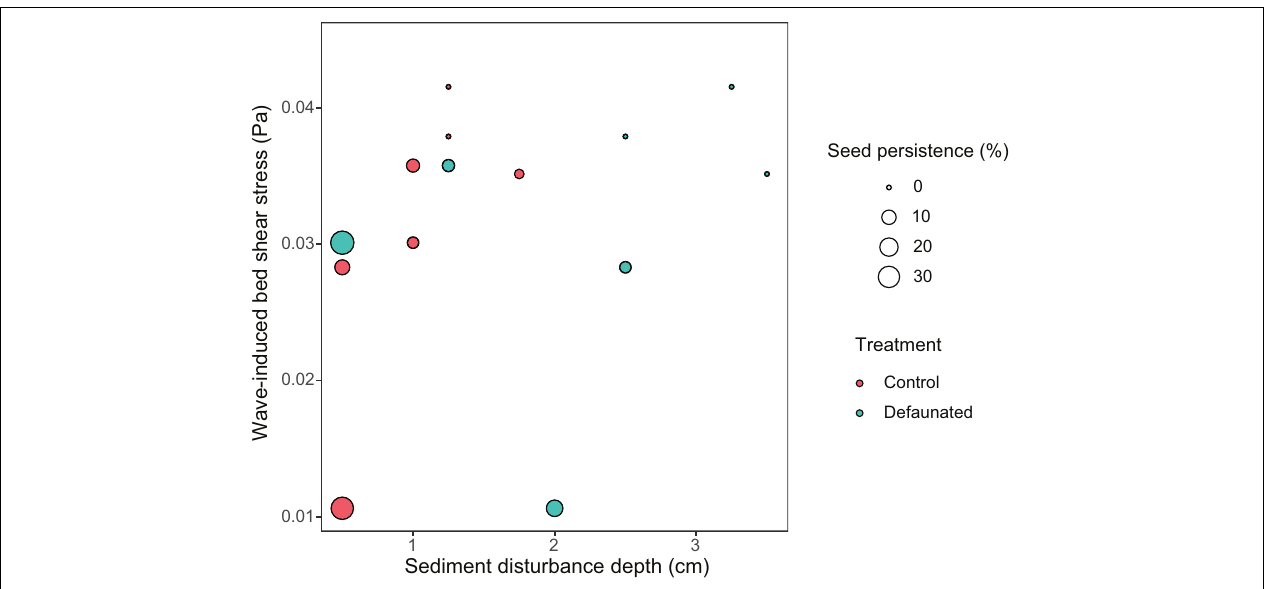
FIGURE 5 | The combined data from the decaudated treatment (green circles) and the control (red circles) showed that, the persistence of seeds on the surface (presented as the size of the circle) decreased with increased wave disturbance and sediment disturbance. Such relationship could be described by the function: z = 0.63 − 0.10 x − 8.46 y, where x is sediment disturbance depth (cm), and y is wave-induced bed shear stress (Pa).